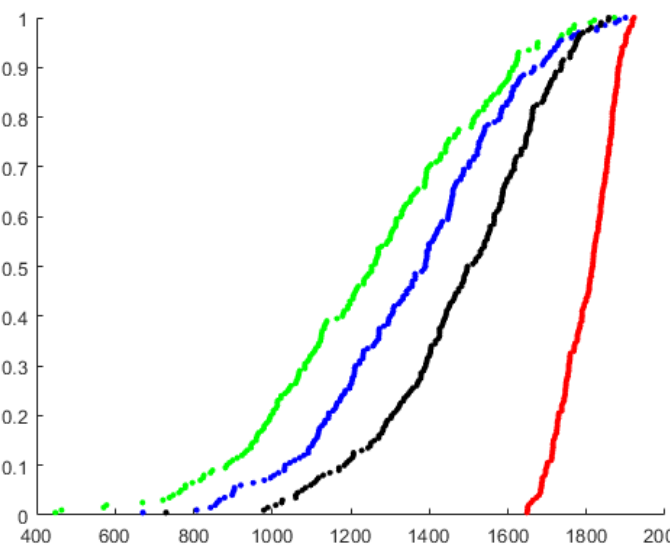
Figure 14. CDF of number of delivered packets ( λ a = 66,000). FIFO; , EDF; , Greedy; ,